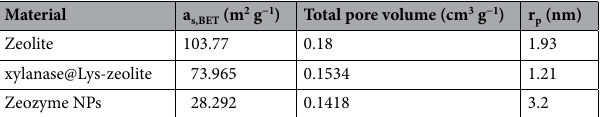
Table 1. The results obtained from BET and BJH of Zeolite and zeozyme NPs.